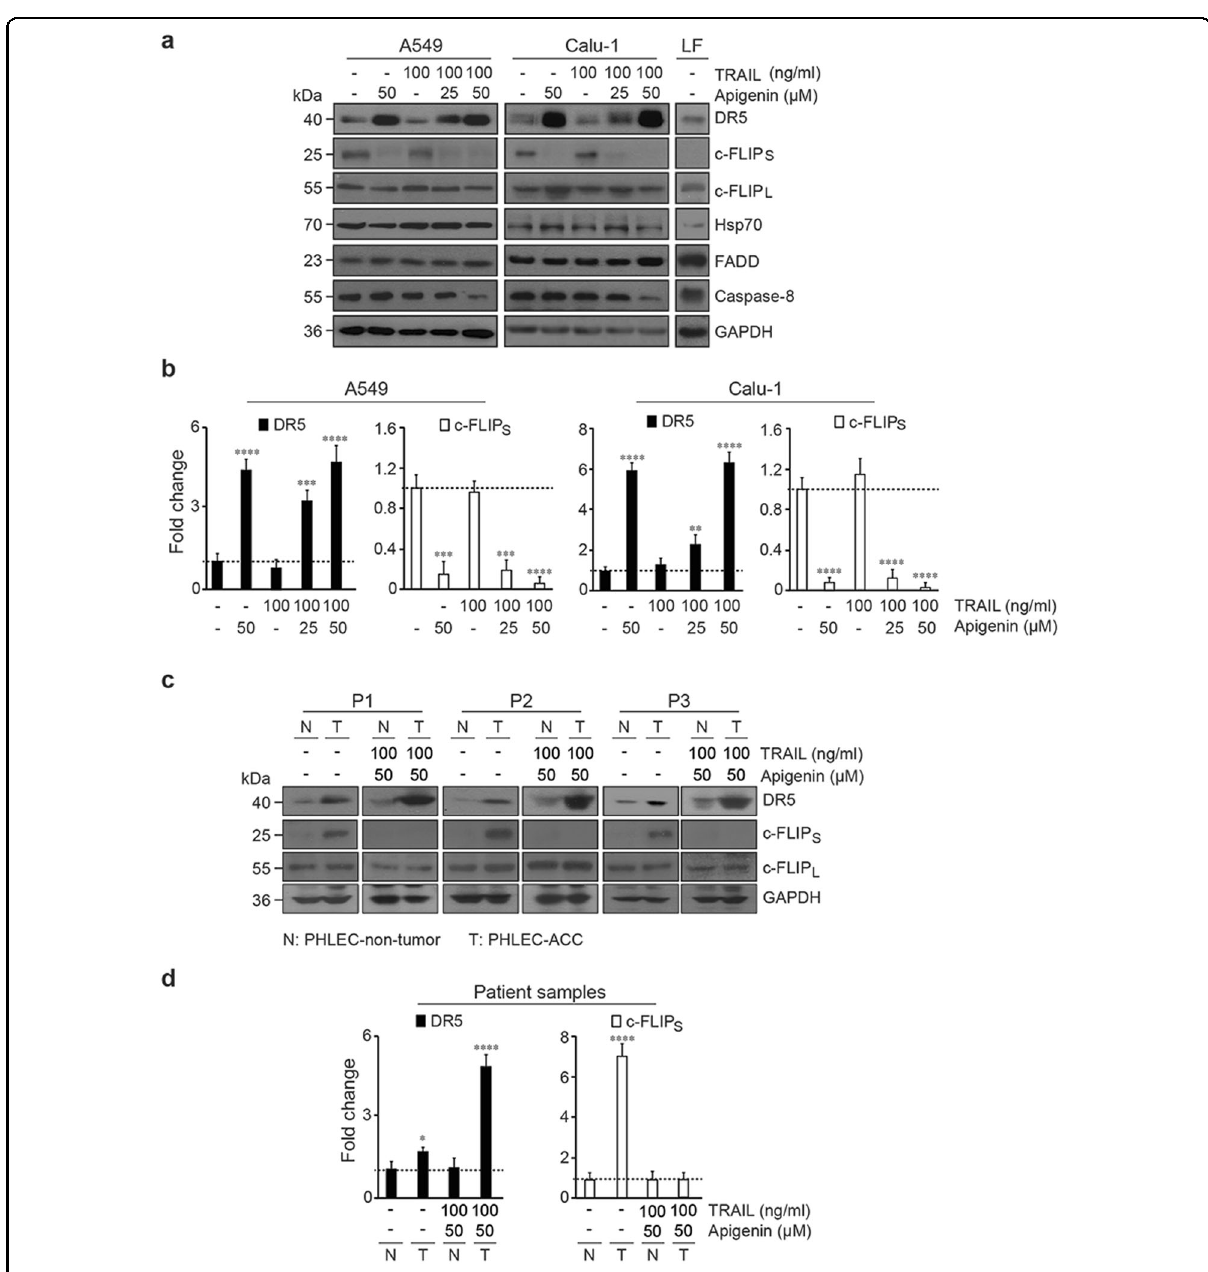
Fig. 2 Apigenin increases DR5 and reduces c-FLIP S protein expression in lung cancer cells. Protein levels of DISC components were assessed by western blot ( a ) for A549 and Calu-1 human NSCLC cell lines and normal nontransformed primary human lung fi broblasts (LF) or ( c ) lung epithelial cells isolated from three paired matched normal (N) human biopsies (nontumor PHLECs) and human tumor (T) biopsies (PHLEC-ACCs) (P1 – P3). The lung cell lines were pretreated with 25 or 50 μ M apigenin for 18 h followed by treatment with 100 ng/ml TRAIL for 6 h, or treated for the whole time with DMSO (-), or 50 μ M apigenin alone, or pretreated with DMSO (-) for 18 h followed by TRAIL for 6 h. The primary epithelial cells were pretreated with 50 μ M apigenin for 18 h followed by treatment with 100 ng/ml TRAIL for 6 h or with only DMSO (-) for the whole time. Protein lysates were assessed by immunoblot with speci fi c anti-DR5, anti-c-FLIP S , anti-c-FLIP L , anti-Hsp70, anti-FADD, and anti-caspase-8 antibodies. The same membranes were reblotted with anti-GAPDH antibodies, which functioned as a loading control. The western blots are representative of three independent experiments. b , d Because DR5 and c-FLIP S appeared to have the most dramatic changes resulting from apigenin treatment, their levels were quanti fi ed by densitometry using ImageJ, and the data are presented as the DR5/GAPDH and c-FLIP S /GAPDH fold-change ratios. The value for the control treatment (-) was established as 1 to enable easy comparison of relative values. All data are presented as the mean ± SEM ( n = 3; * P < 0.05, ** P < 0.01, *** P < 0.001, and **** P < 0.005; and analyses were performed by two-way